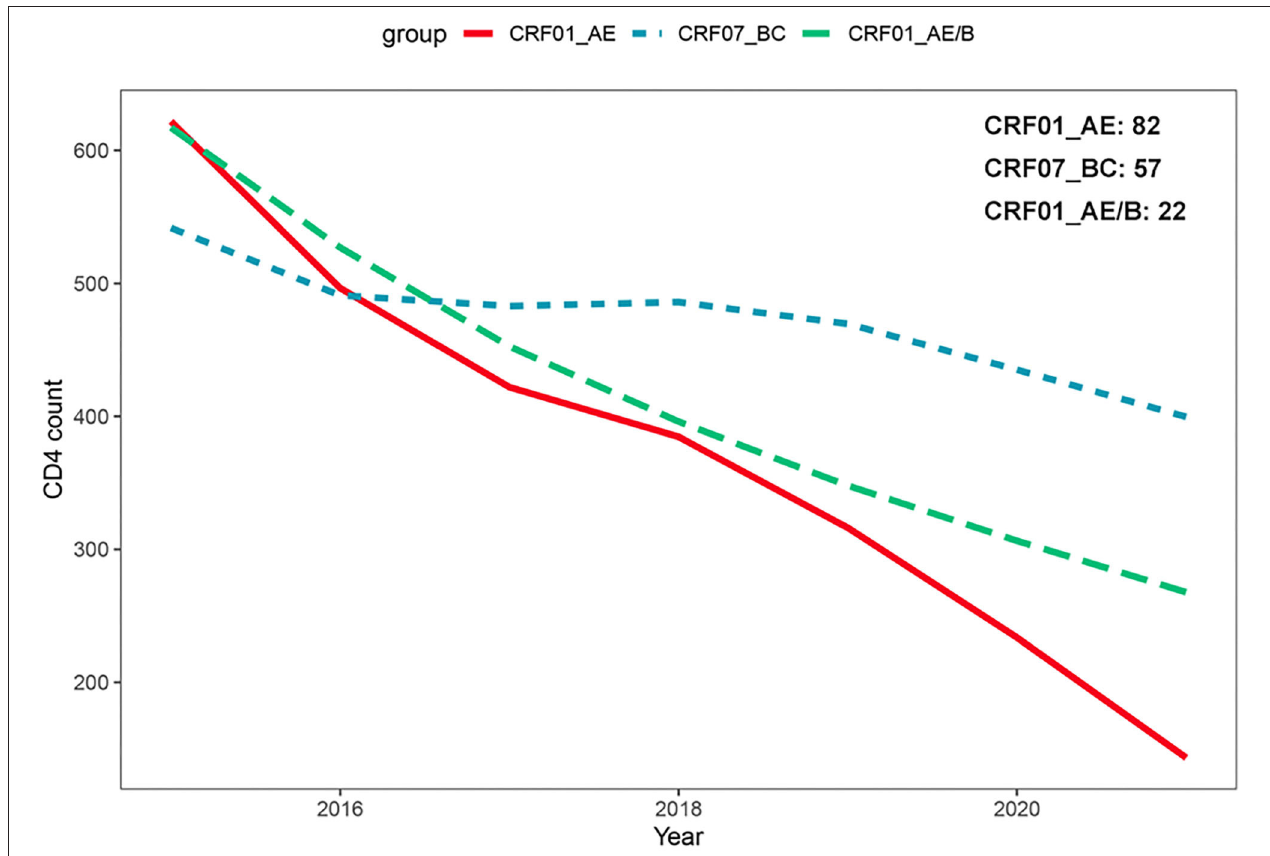
FIGURE 4 | Comparison of CD4 + T-cell count change over time among different HIV-1 recombinant profiles based on generalized additive mixed model. The decline rate of CD4 + T-cell count in patients with CRF01_AE/B recombinants was significantly faster than CRF07_BC patients (interaction P < 0.01) but not different from CRF01_AE patients (interaction P =